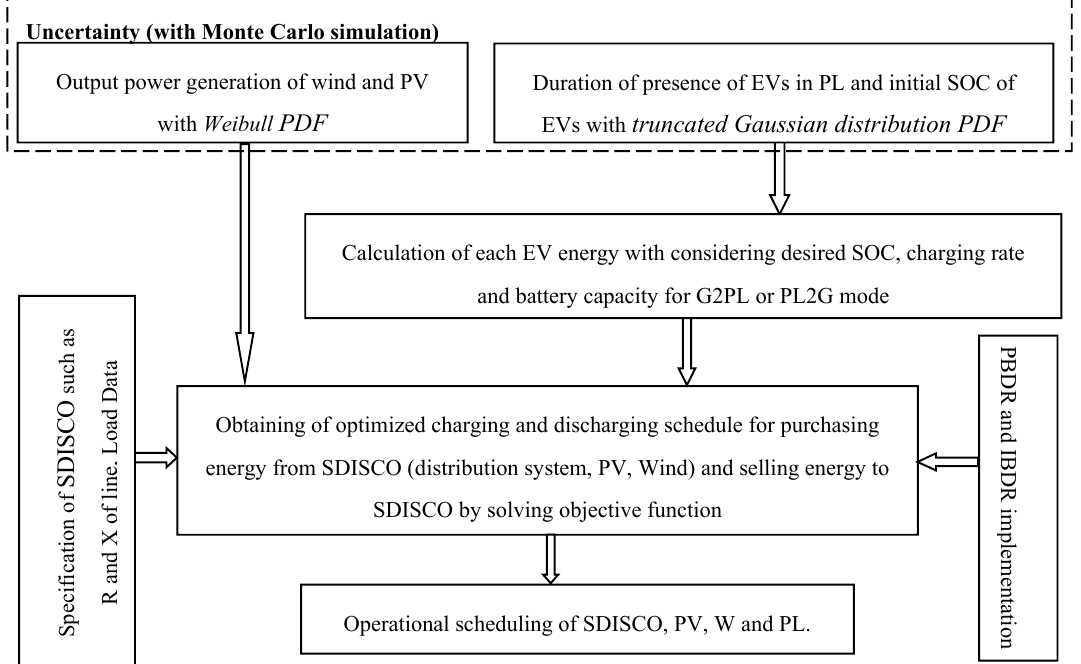
Figure 2. Process solving of operational scheduling of smart distribution company (SDISCO). PBDR, price-based demand response; IBDR, incentive-based DR.